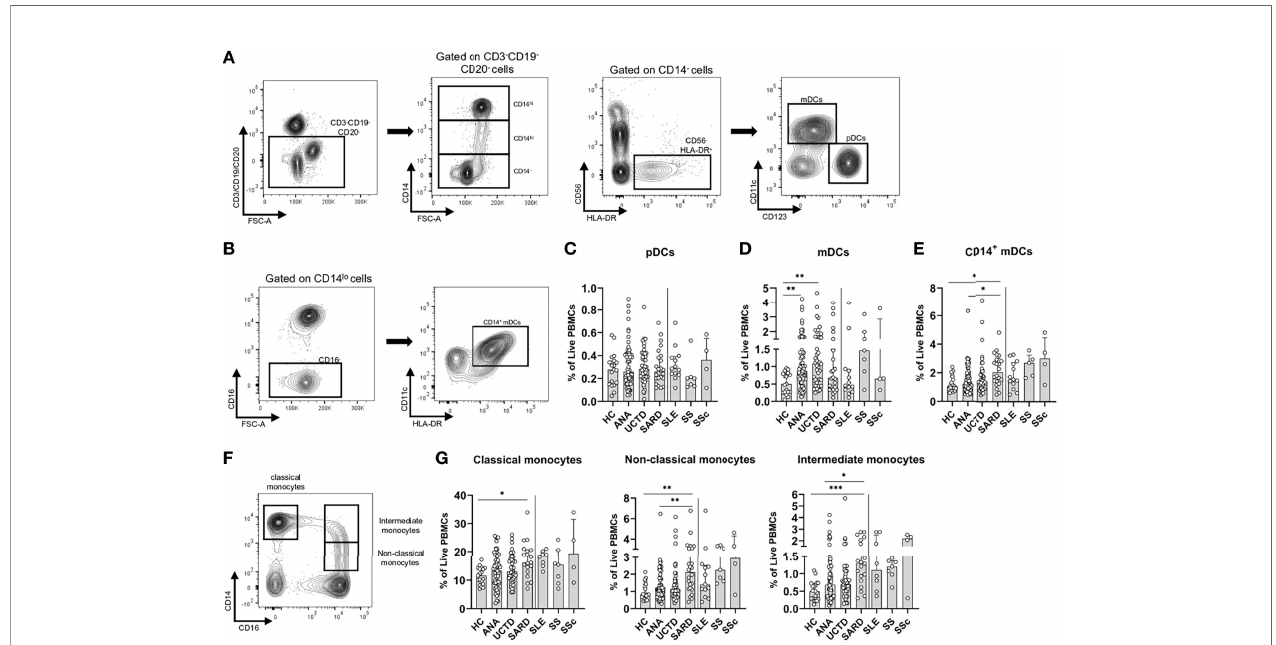
FIGURE 3 | Differences in the frequencies of innate immune populations distinguish anti-nuclear antibody positive (ANA + ) individuals lacking a systemic autoimmune rheumatic diseases (SARD) diagnosis from early SARD patients. (A) Gating strategy for identi fi cation of CD14 - HLA-DR + CD56 - plasmacytoid dendritic cells (pDCs, CD123 + CD11c - ) and myeloid dendritic cells (mDCs, CD123 - CD11c + ) from the lineage negative compartment (CD3 - CD19 - CD20 - ) in a representative ANA + patient. (B) Gating strategy for identi fi cation of CD14 + mDCs (CD14 lo CD123 - CD11c + ). (C – E) The proportion of pDCs, mDCs, and CD14 + mDCs strati fi ed by subject group. (F) Gating strategy for identi fi cation of classical monocytes (CD16 - CD14 hi ); non-classical monocytes (CD16 + CD14 lo ); and intermediate monocytes (CD16 + CD14 - ). (G) The proportion of the monocyte subsets strati fi ed by subject group. The solid vertical line in each plot separates the groups that were statistically compared to one another from the individual SARD on the right, which were not statistically compared to any group. Bars represent the median with interquartile range. Each data point represents an individual subject. Statistical signi fi cance was determined using the Kruskal-Wallis test with Dunn ’ s post-hoc test for multiple comparisons. *p ≤ 0.05, **p ≤ 0.01, ***p ≤ 0.001. HC, ANA - healthy control; ANA, asymptomatic ANA + ; UCTD, undifferentiated connective tissue disease; SARD, systemic autoimmune rheumatic disease; SLE, systemic lupus erythematosus; SS, Sjögren ’ s syndrome; SSc, systemic